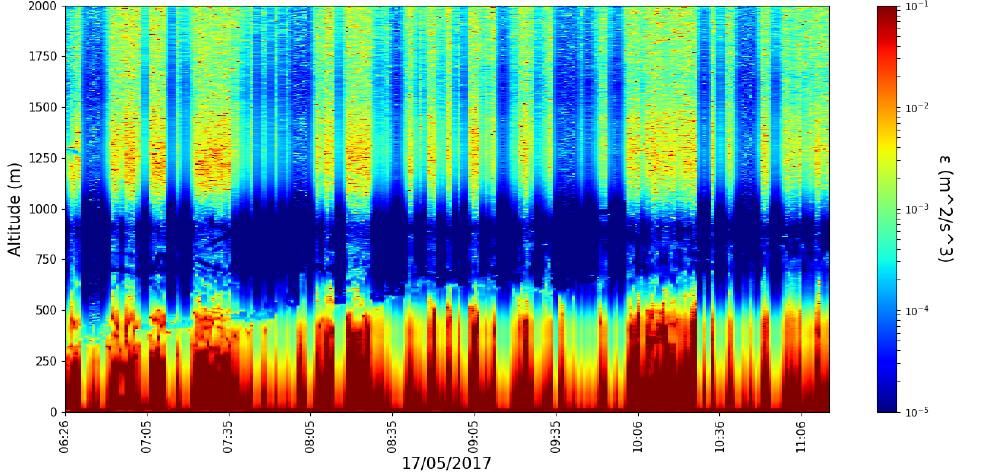
Figure 13. 𝜀 profile timeseries, profiling rate 1/min, 17 April 2017. Figure 13. ε profile timeseries, profiling rate 1/min, 17 April